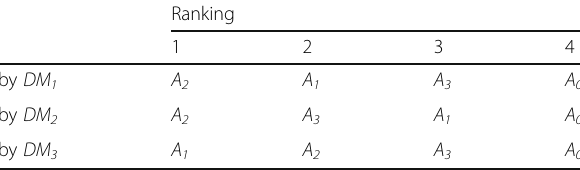
Table 9 Ranking of alternatives by each decision maker